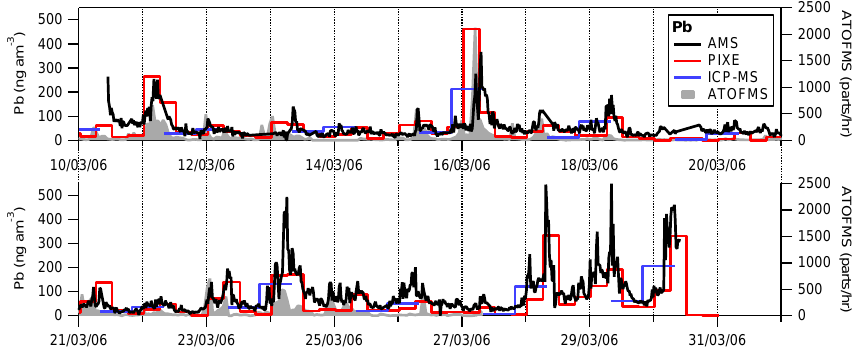
Fig. 8. Time series of Pb measurements at T0: HR-AMS (black line), PIXE (red bars; Moffet et al., 2008a), and ICP-MS (blue bars; Moreno et al., 2008; Querol et al., 2008) mass concentrations, and ATOFMS signals in particle counts per hour (grey filled area) (Moffet et al., 2008a,